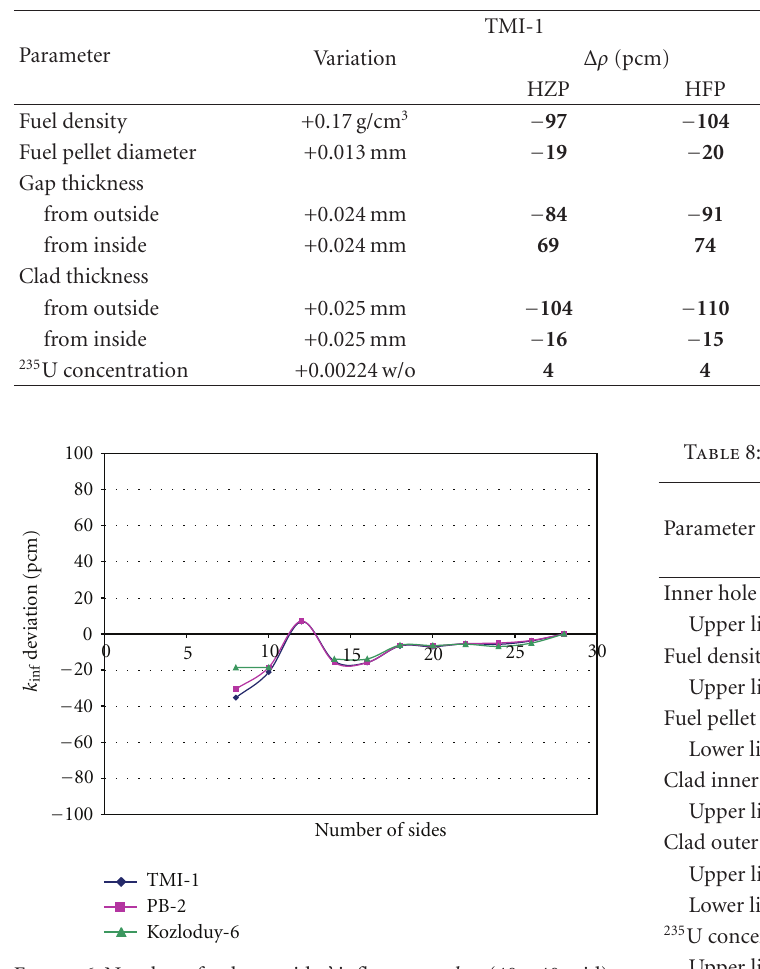
Table 7: Manufacturing sensitivities for TMI-1 and PB-2 test cases.